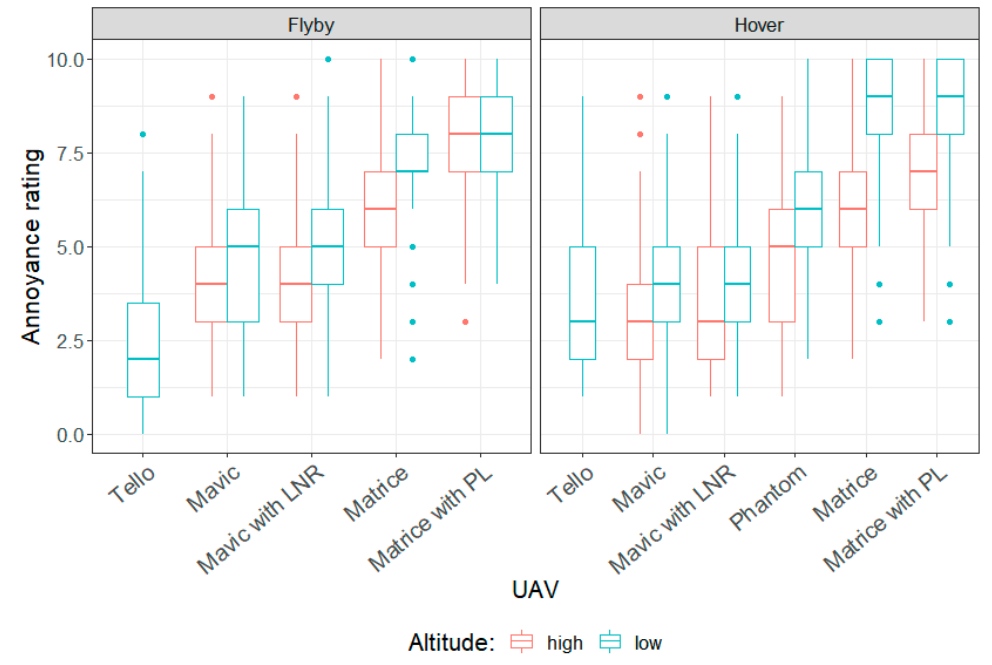
Figure 7. Responses from annoyance rating test.